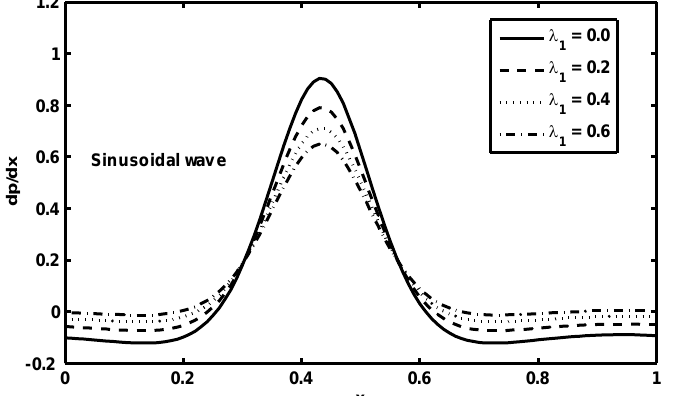
Fig. 5 Figure 5. Variation of π = 0.4 η = 0.5, λ = 0.3, k = 0.1, Q = 1. , η 4 1 2 1